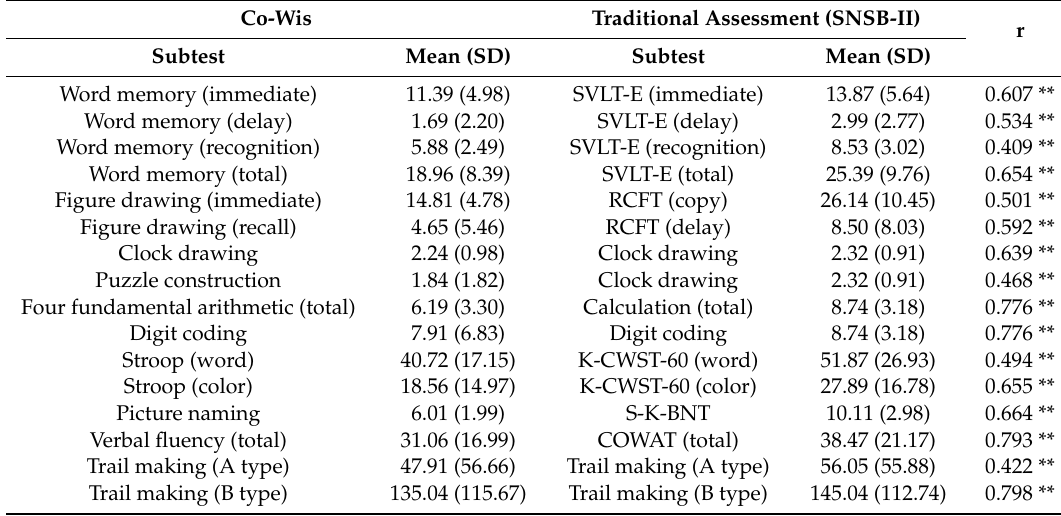
Table 3. Concurrent validity of Co-Wis.